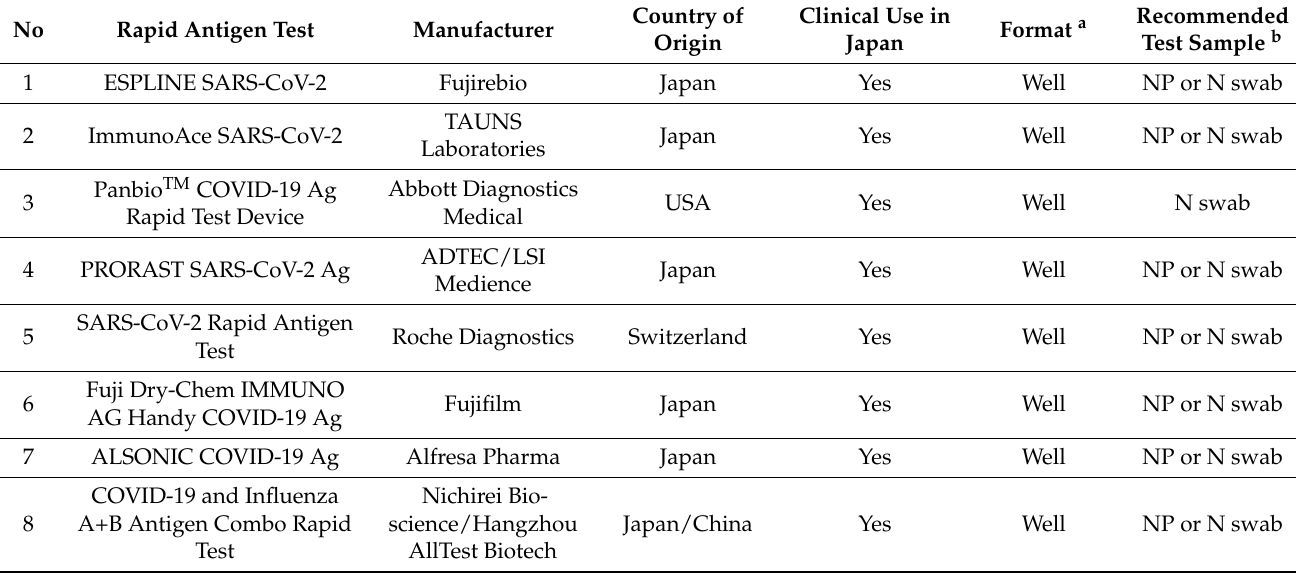
Table 1. Characteristics of the rapid antigen tests for COVID-19 evaluated in this study. No Rapid Antigen